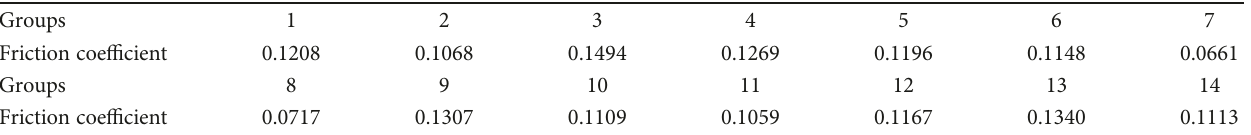
Table 4: Friction coe ffi